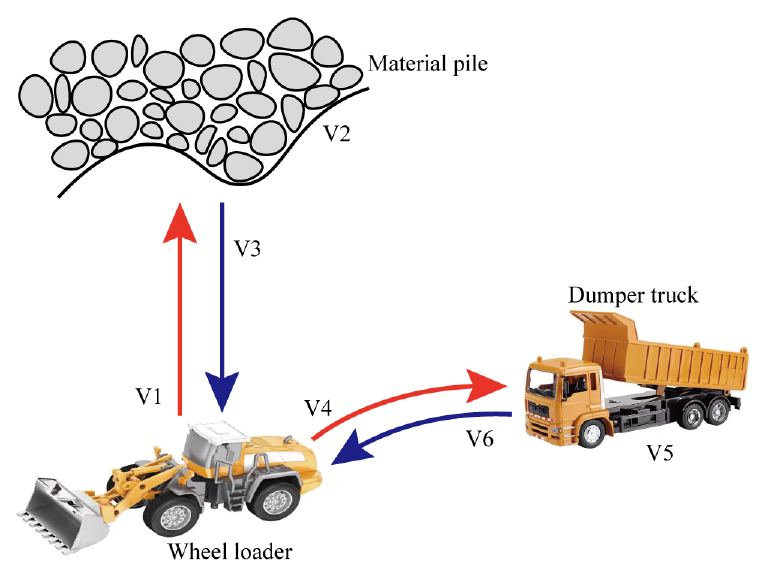
Figure 1. V-cycle of wheel loaders.